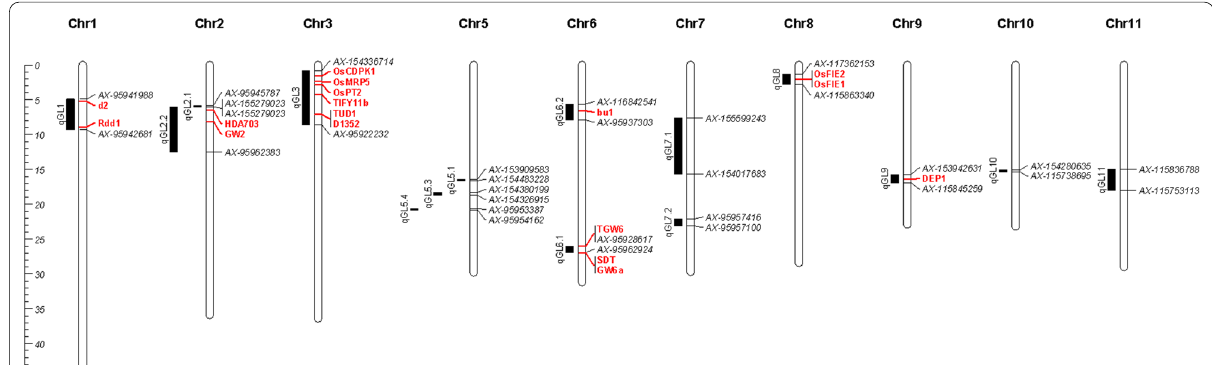
Fig. 2 Physical map showing the QTLs identified for grain length in RIL population by individual environmental analyses. Red font, known genes; black font, the markers and QTL detected in this study